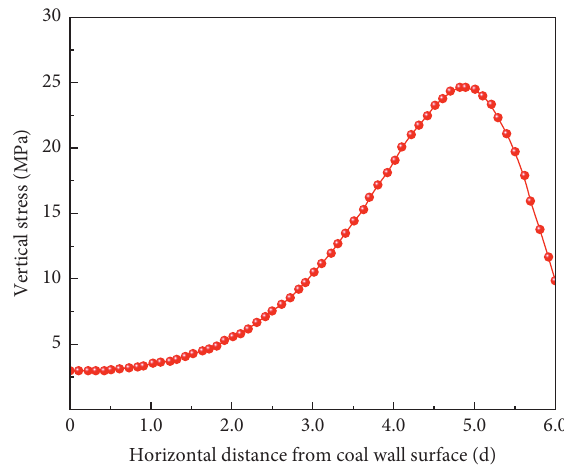
Figure 3: Variation curve of vertical stress in coal wall of roadway.